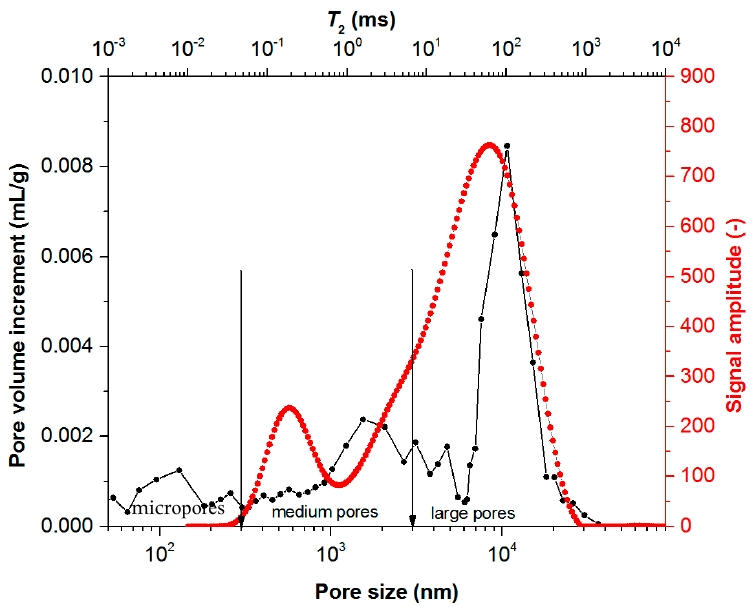
Figure 6. High − pressure mercury intrusion curve and T 2 spectrum curve of sandstone (Vertical lines represent the dividing lines of three different sizes of pores).